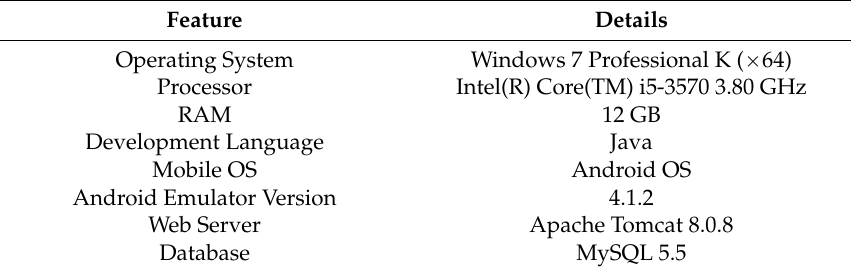
Table 1. Development environment.